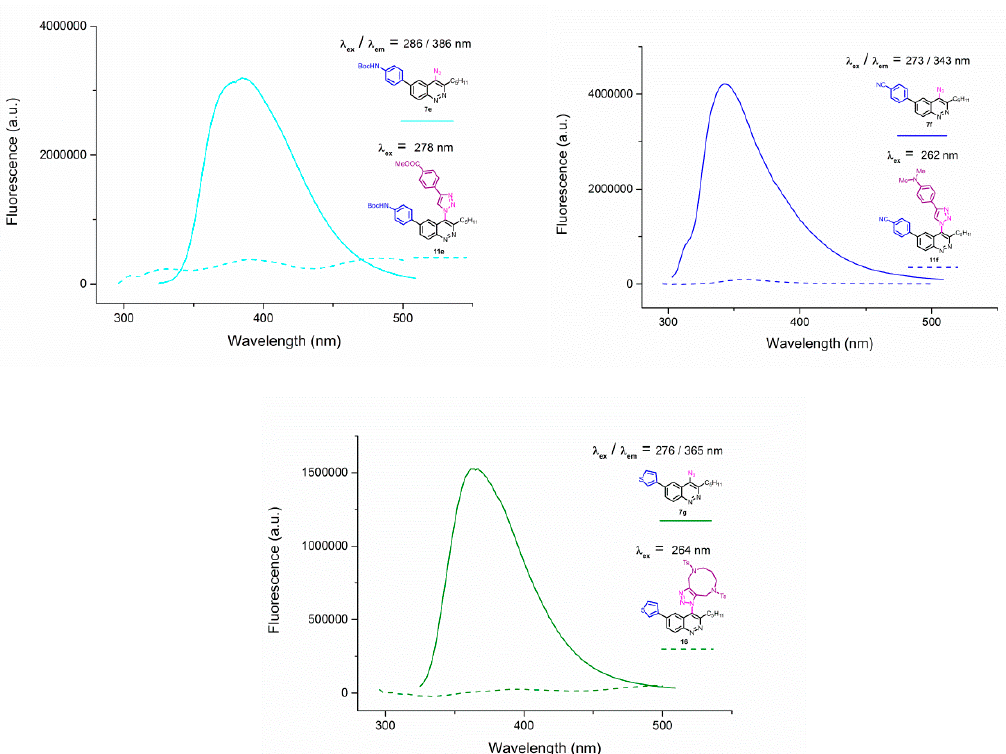
Figure A2. Emission spectra of 4-azidocinnolines / 4-triazolylcinnolnes 7a/11a; 7b/11b; 7e/11e; 7f/11f; 7g/16 solutions in THF, C = 1 × 10 − 5 mol/L.